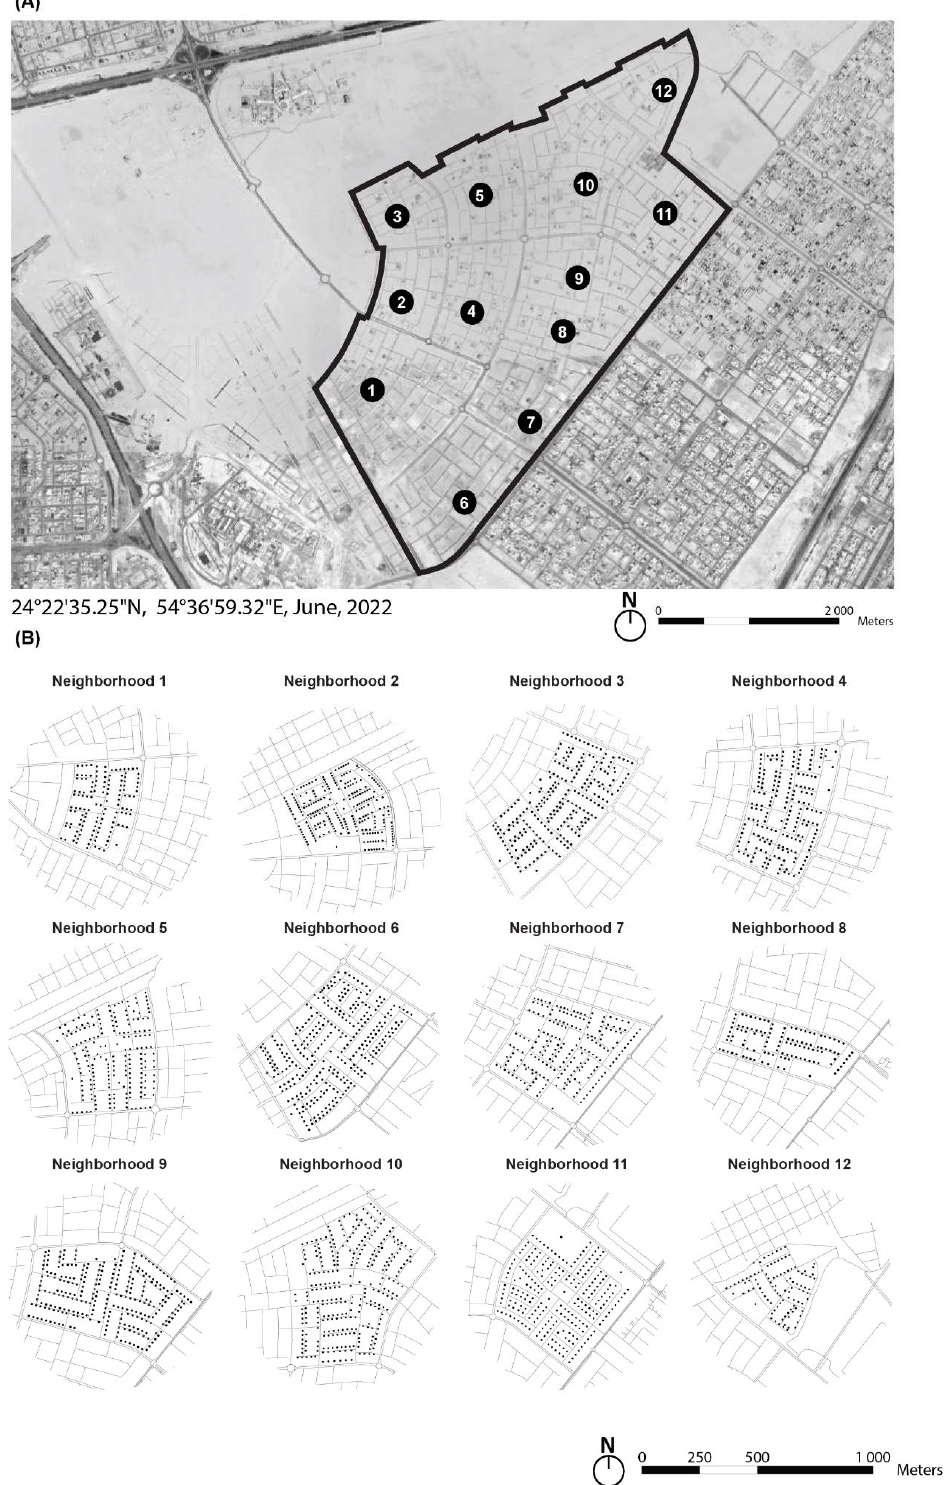
Figure 3. ( A ). The current stage of development of the Capital District in addition to the location of the 12 neighborhoods, June 2022; ( B ) illustrates street networks and dots representing plots.